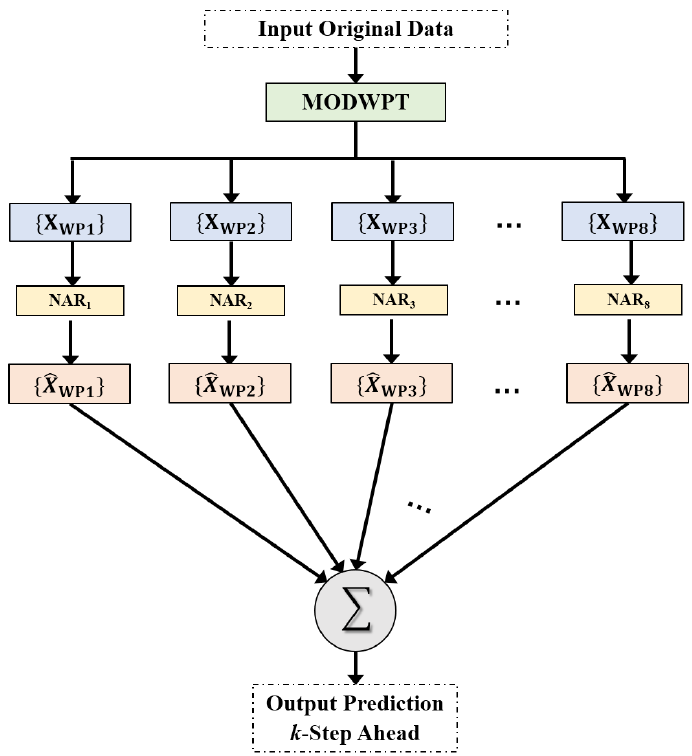
Figure 4. MODWPT-NAR neural network